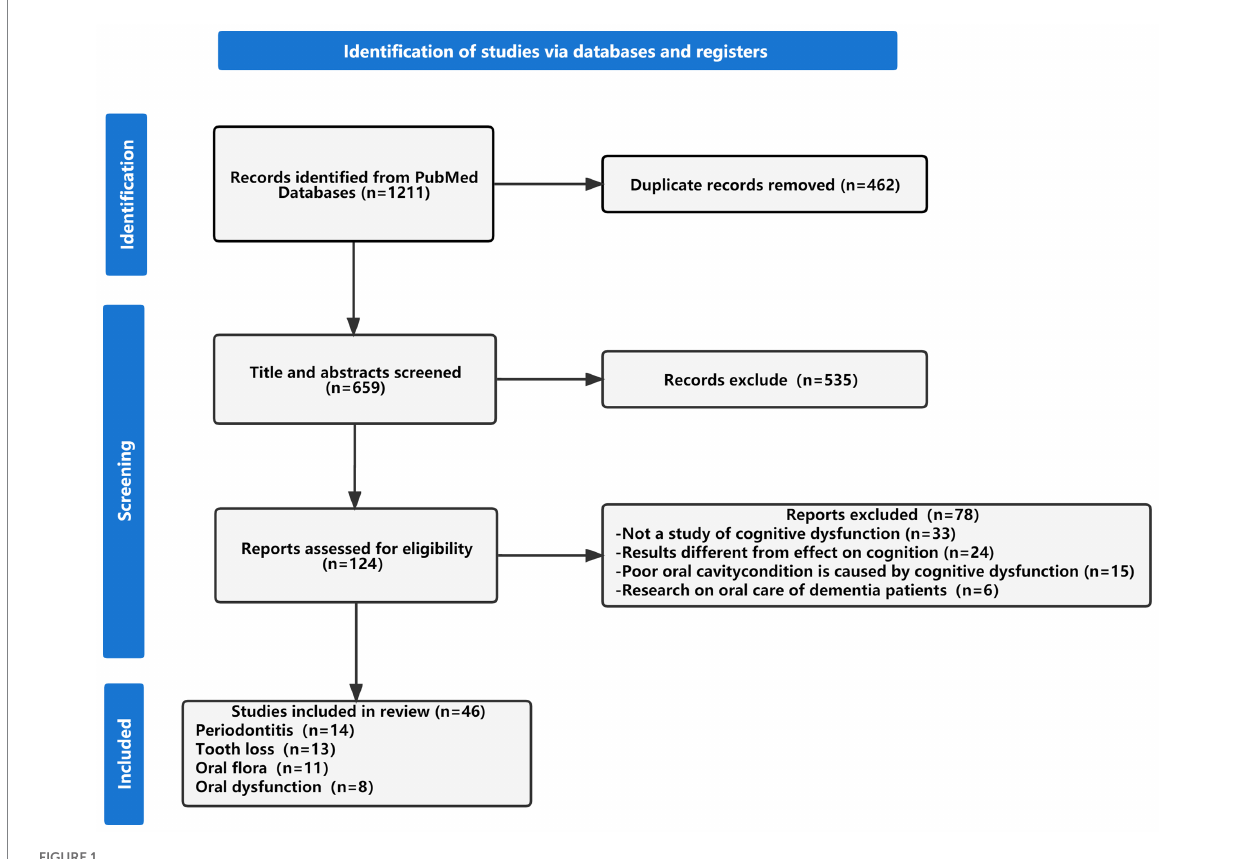
FIGURE 1 Flow chart of the literature search and study selection